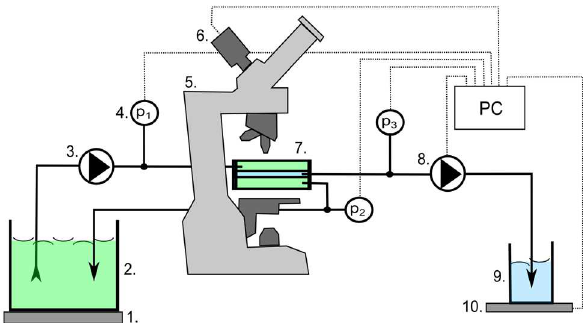
Fig. 2. The diagram of the experimental setup (1. Magnetic stirrer, 2. Beaker for bentonite solution, 3. gear pump, 4. Pressure transducers, 5. Optical microscope, 6. Digital camera, 7. Cross-flow filtration channel equipped with a hollow fiber membrane, 8. Peristaltic pump, 9. Beaker for permeate, 10. Digital balance). Feed Permeate Fig. 3. The cross-flow filtration channel, depicting the feed flow, permeate suction point and the locations of fouling observation